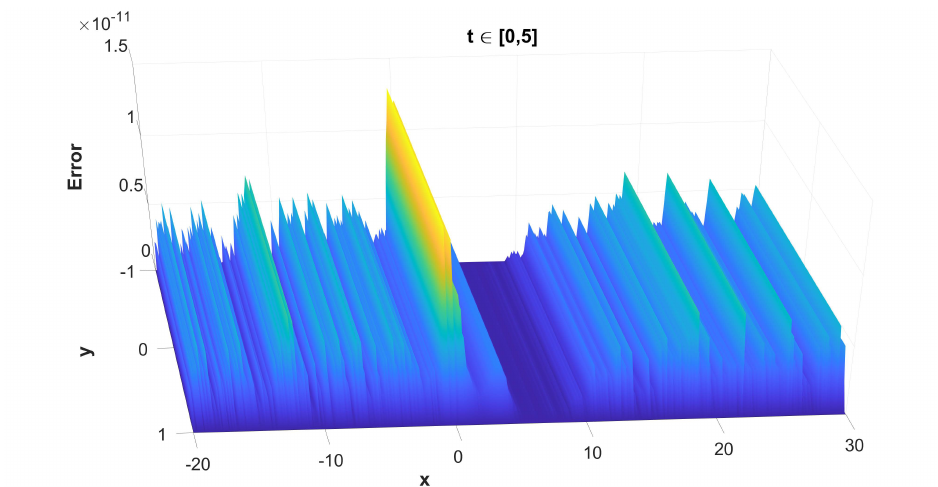
Figure 8. The maximum, along t , absolute error of the solution versus x and y without the use of finite difference schemes for the spatial semi-discretisation.